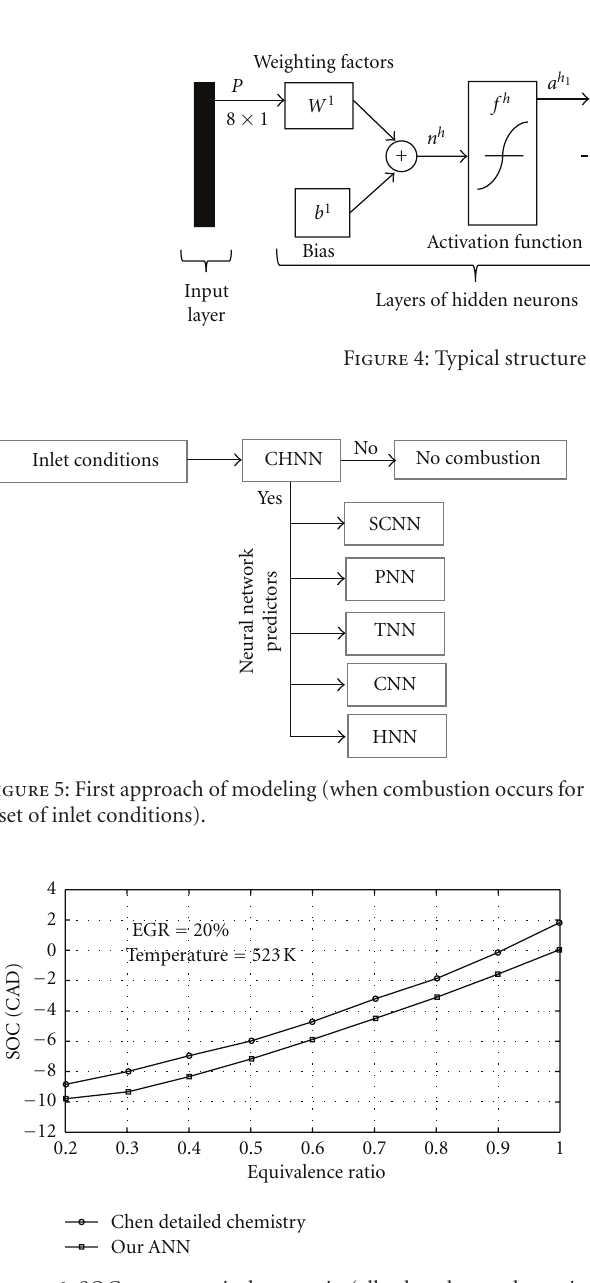
Figure 6: SOC versus equivalence ratio (all other thermodynamic conditions and engine geometry are the same).